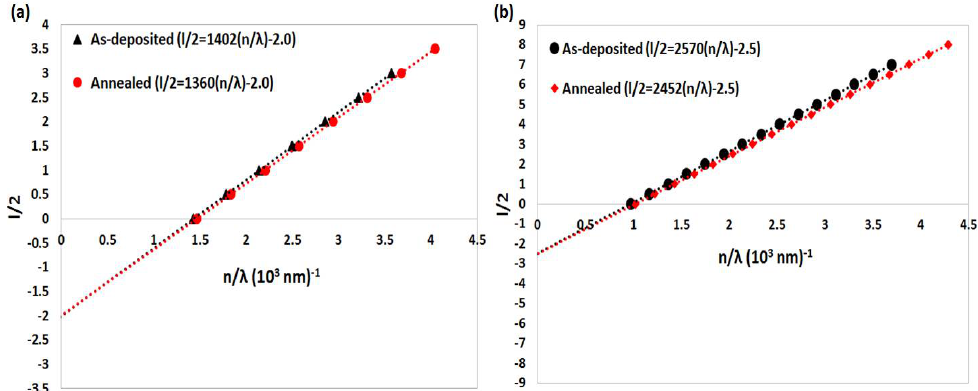
Figure 6. Plots of (l/2) versus (n/λ) to determine the physical film thickness and the first-order value m 1 for as-deposited and annealed garnet thin films, according to the modified Equation (8). Film thickness ( a ) 701 nm, and ( b ) 1272 nm.